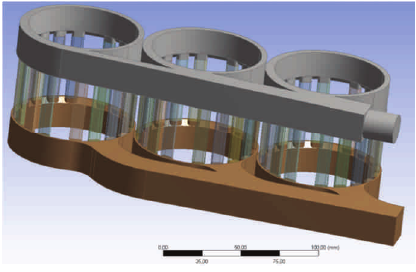
Fig. 9. Model for reducing flow resistance